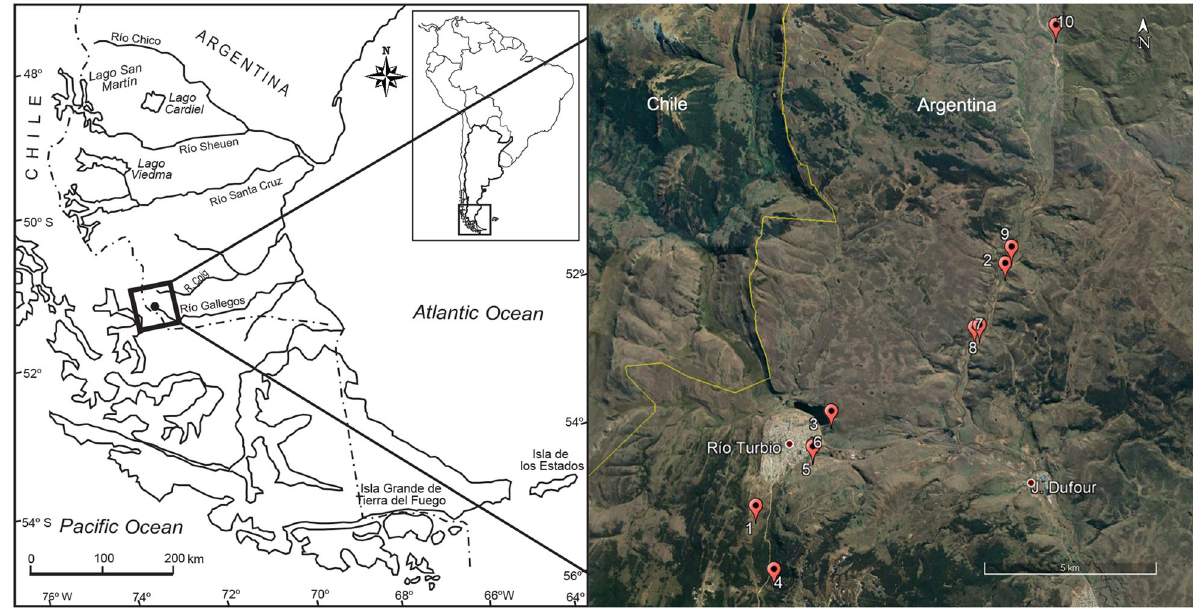
Fig. 1 Study area. Location map showing distribution of Eocene sedimentary rocks of the Río Turbio Formation, Santa Cruz Province, Patagonia, southern South America.